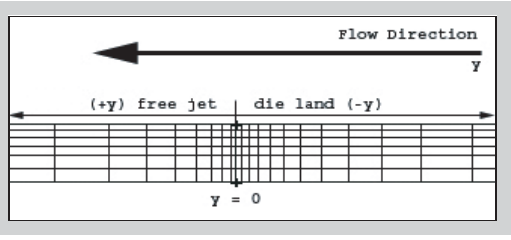
Figure 3: Central portion of